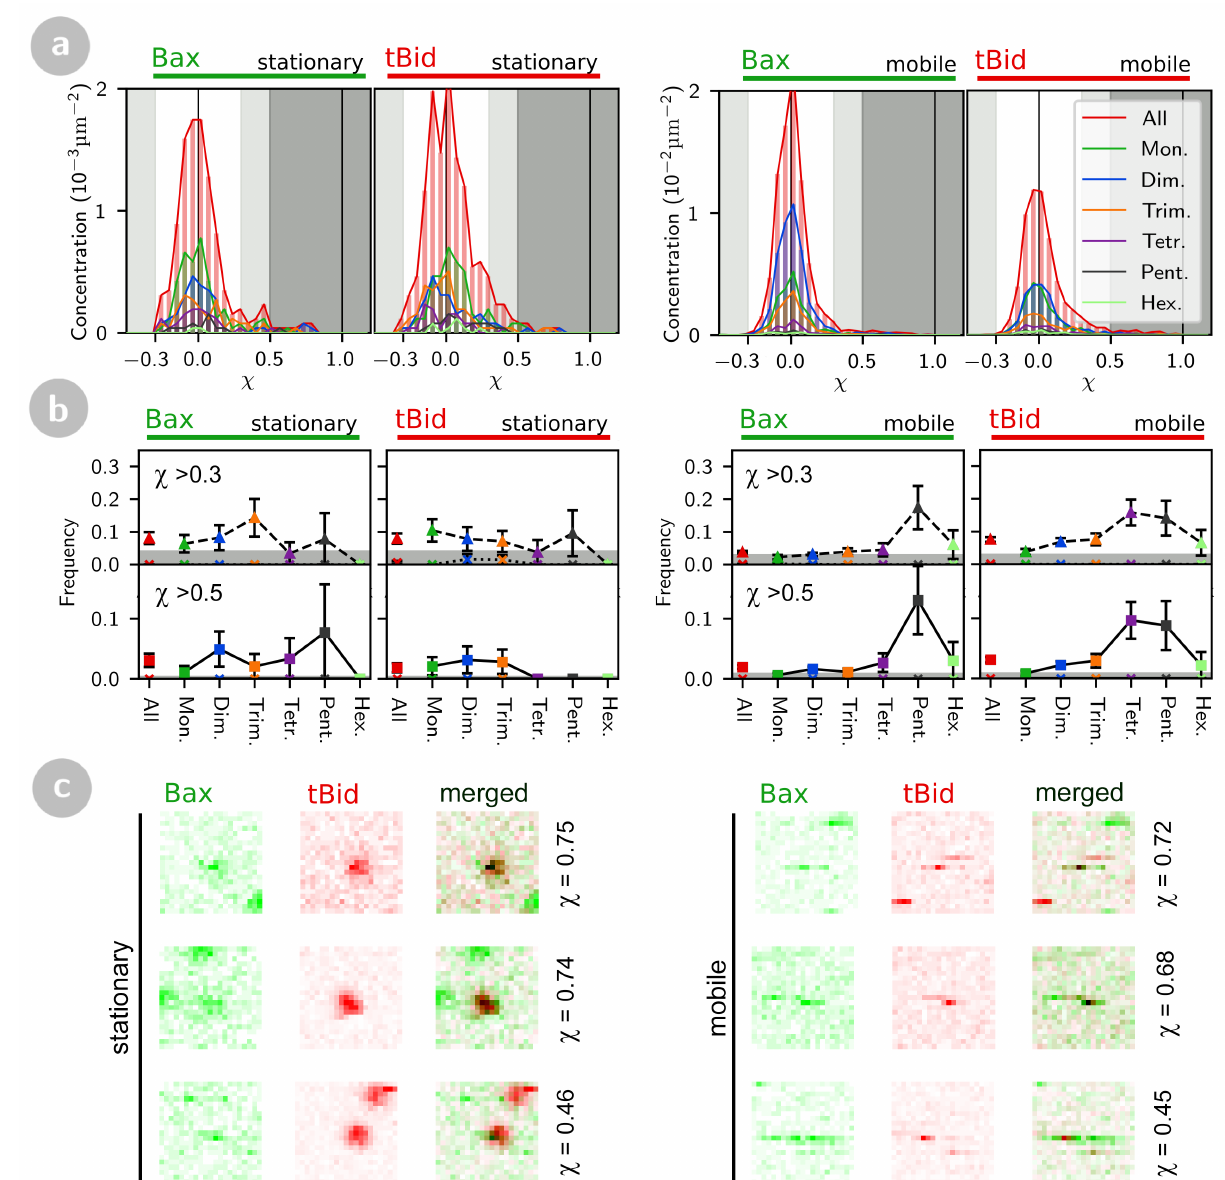
Figure 6. Particle cross-correlation coefficients measured for stationary and mobile tBid and Bax oligomers. ( a ) Cross- correlation coefficient distributions for all oligomers. The light grey areas correspond to slight cross- or anti-correlation (0.3 < χ < 0.5 or − 0.5 < χ < − 0.3) and the dark grey area highlights strong cross-correlation ( χ > 0.5). ( b ) Fraction of correlated particles ( χ > 0.3, upper panels, triangles and dashed lines) and strongly correlated particles ( χ > 0.5, lower panels, squares and continuous lines) in each oligomer class. The highlighted areas show the absolute maximum amount of accidental positive correlations to be expected given a particle concentration similar to that observed in experiments (0.05 particles/µm 2 for stationary particles and 0.15 particles/µm 2 for mobile particles), as obtained from the simulations shown in Figure 5b,c. In each panel, the fraction of detected anti-correlated particles ( χ < − 0.3 or χ < − 0.5) are also shown (X symbols and dotted lines). ( c ) Representative examples of detected particle pairs with either slight or strong correlation. The shown particle cross-correlation coefficient is the one calculated for the green